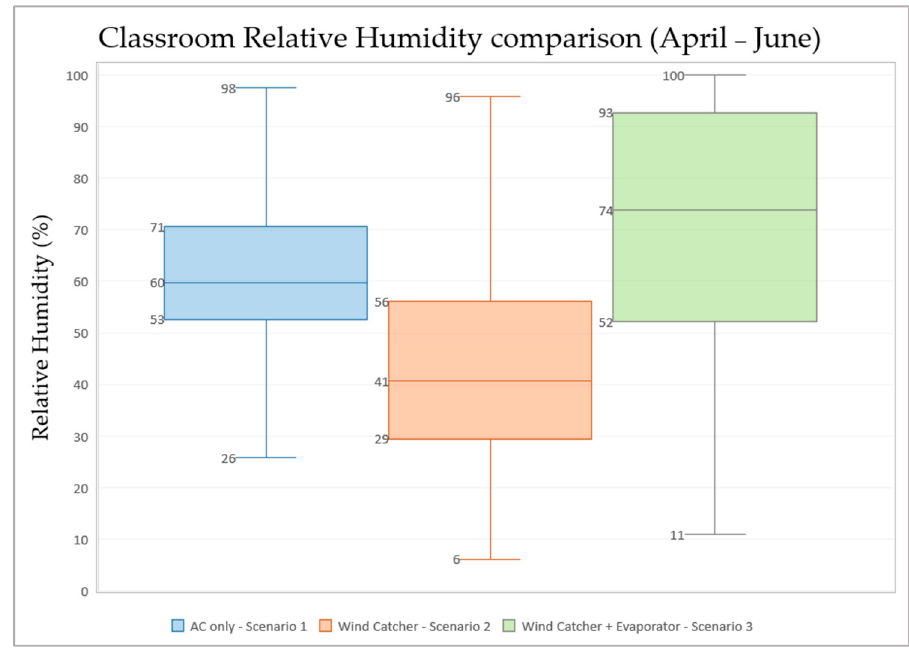
Figure 13. Relative humidity comparison across the three scenarios.